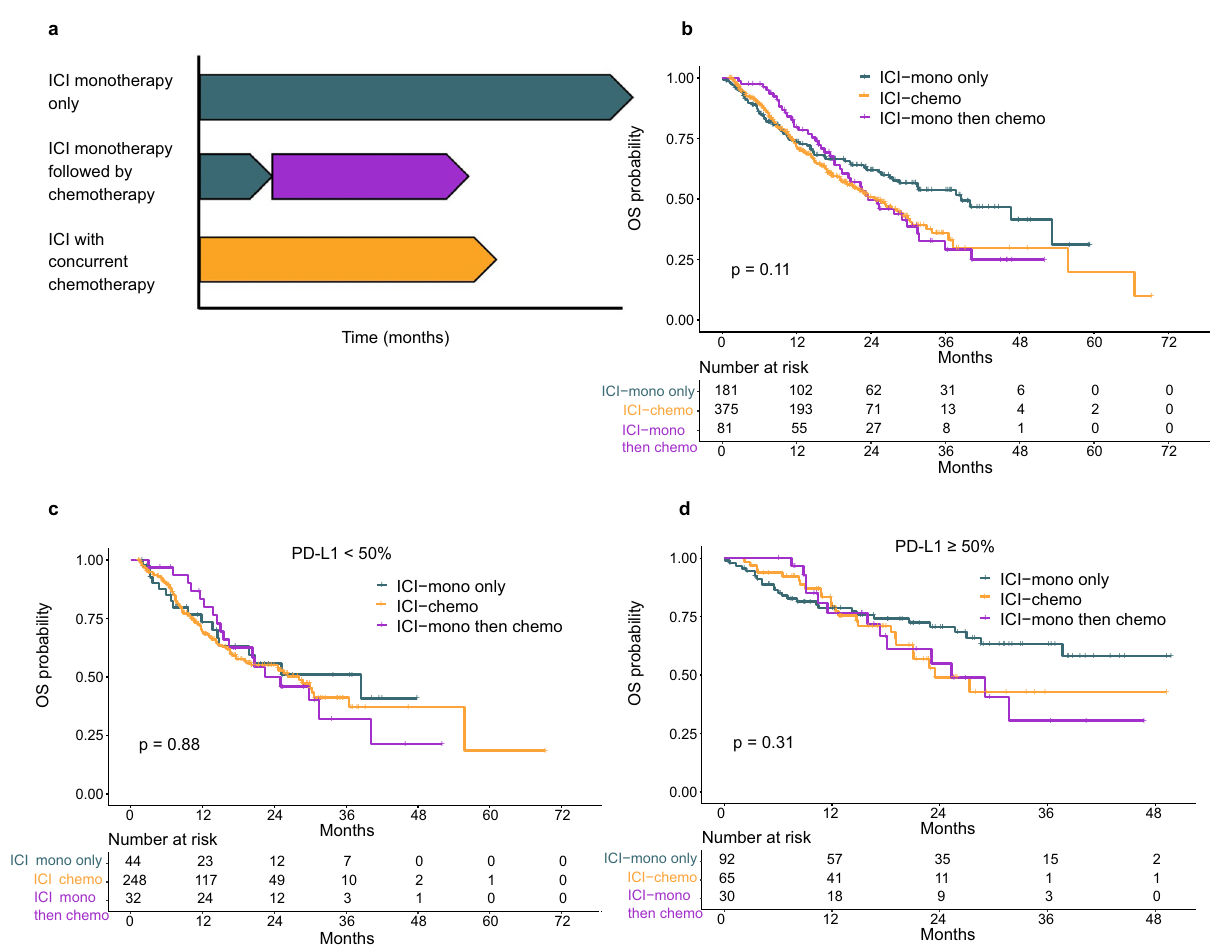
Fig. 2 | Subgroup analyses of overall survival (OS) in MDACC-primary cohort fi rst-line patients ( n =675) strati fi ed by chemotherapy administration in the 2nd line. a Analysis schema. b Kaplan – meier plot of OS of all fi rst-line patients strati fi ed by sequential vs combination chemotherapy; c OS in patients with PD-L1 intermediate (1% – 49%) or low (0 or <1%); and d OS in patients with PD-L1